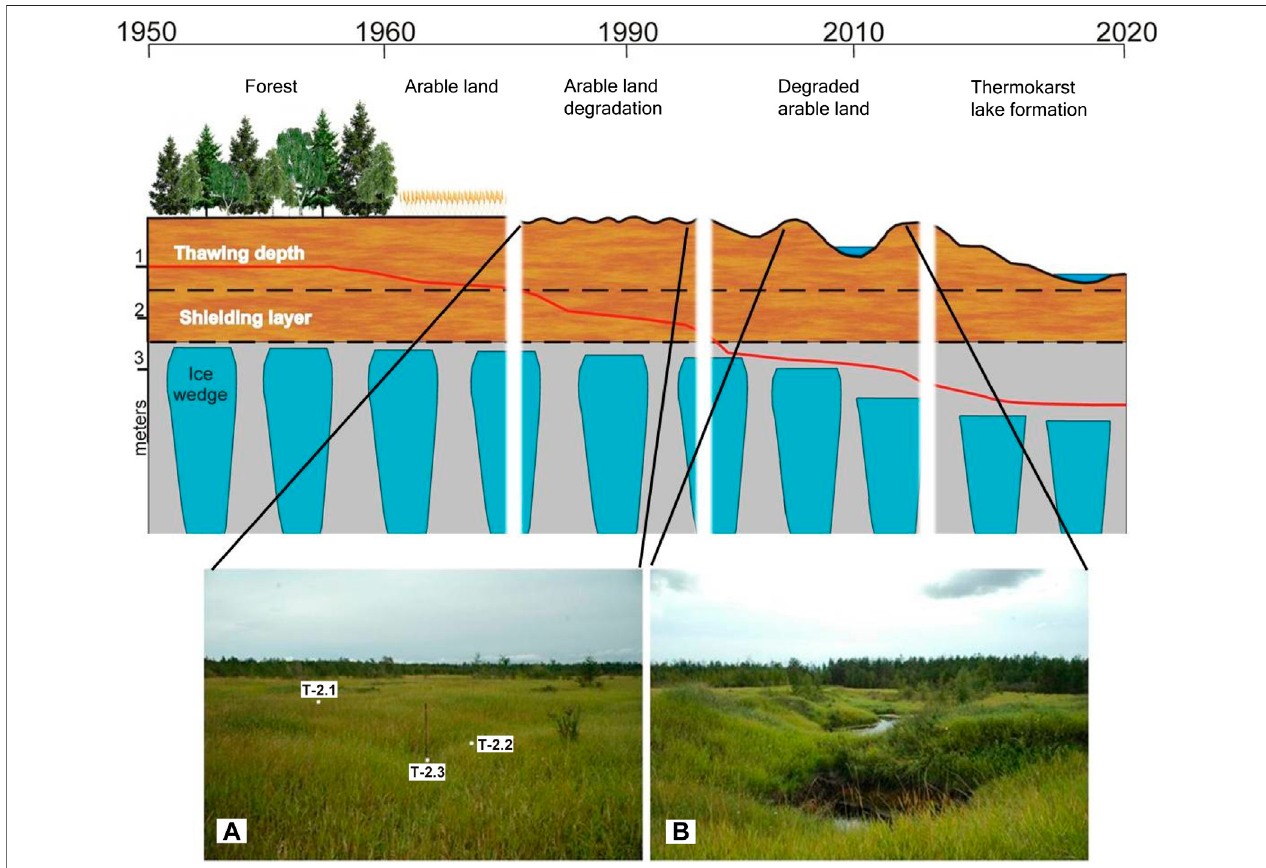
FIGURE 5 | Development scheme, general view, and location of studied soil pits on the former arable fi eld (Tabaga site) abandoned in the 1970s – 1980s and subjected to thermokarst with the formation of (A) byllar and (B) dyuedya microtopography.